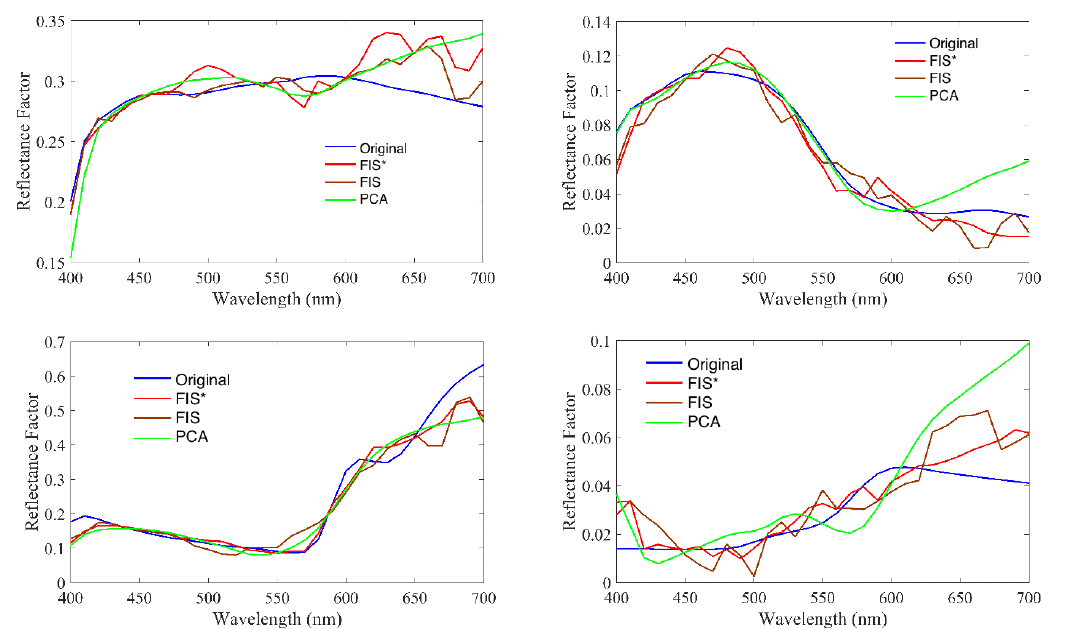
Figure 9. Original and recovered randomly selected testing samples using the recovery methods from CIEXYZ data in the